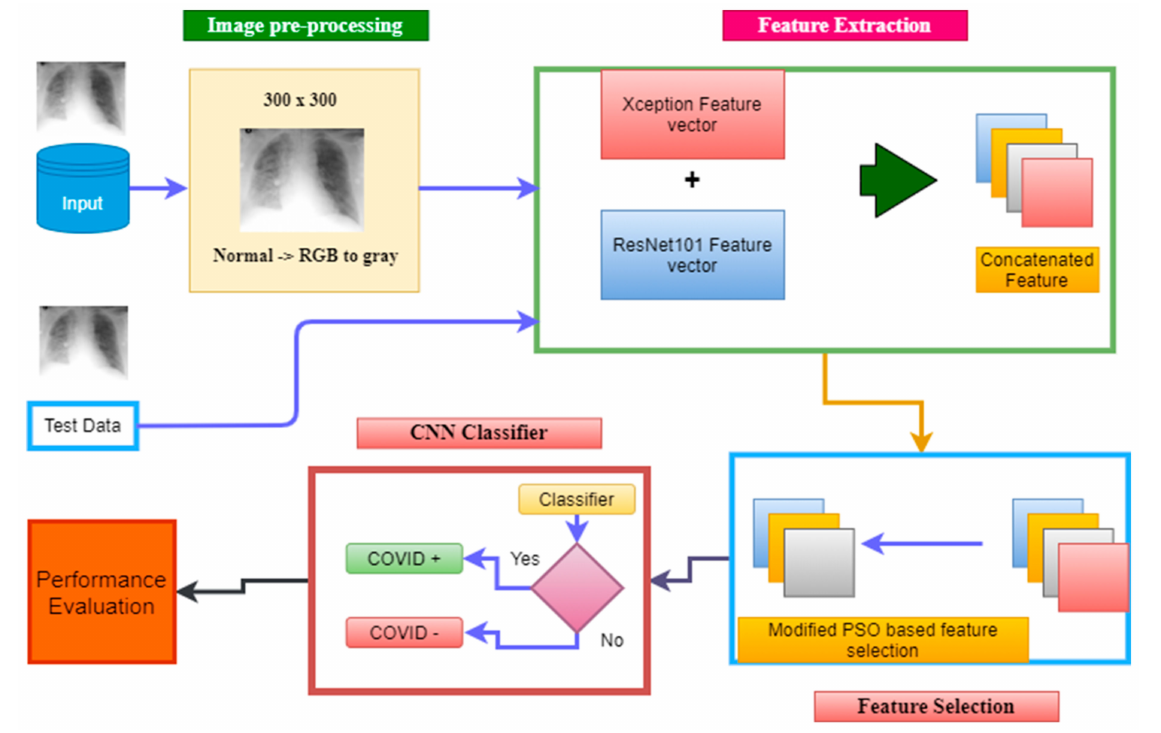
Figure 2. The architecture of the proposed framework.